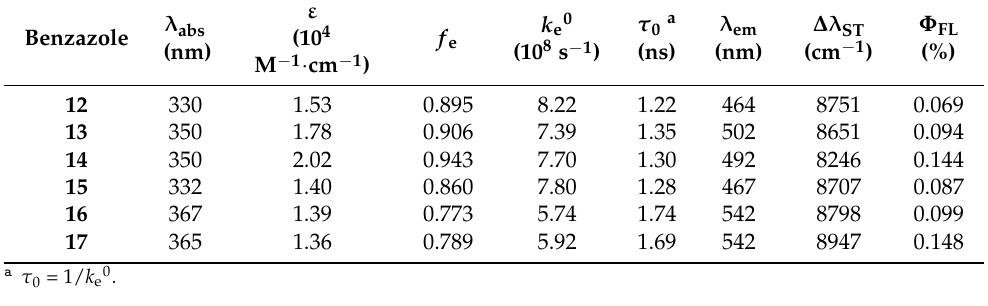
Table 1. Photophysical data of ESIPT fluorescent lipophilic benzoxazoles 12 – 17 from UV-Vis absorp- tion and fluorescence emission spectroscopies, where ε is the molar extinction coefficient, λ abs and λ em are the absorption and emission maxima, respectively, f e is the calculated oscillator strength, k e 0 is the calculated radiative rate constant, τ 0 is the calculated pure radiative lifetime, ∆ λ ST is the Stokes shift, and Φ FL is the fluorescence quantum yield.